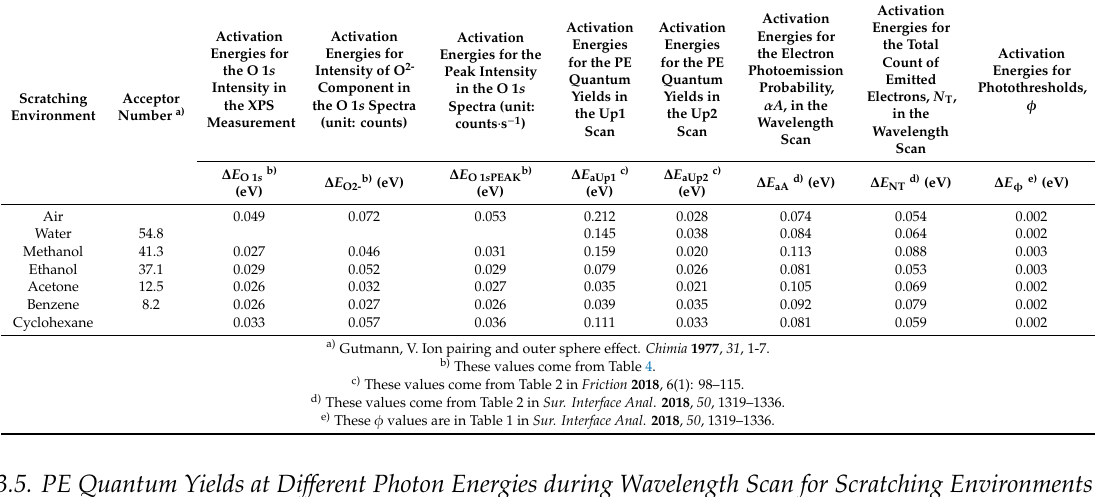
Table 5. Relationship between acceptor number of the environment molecules, Arrhenius activation energies obtained from the XPS data in the XPS measurement, those for the PE quantum yields during the temperature scans, and those for the PE characteristics of the electron photoemission probability, total count of emitted electrons, and photothresholds obtained from the PE measurement during the wavelength